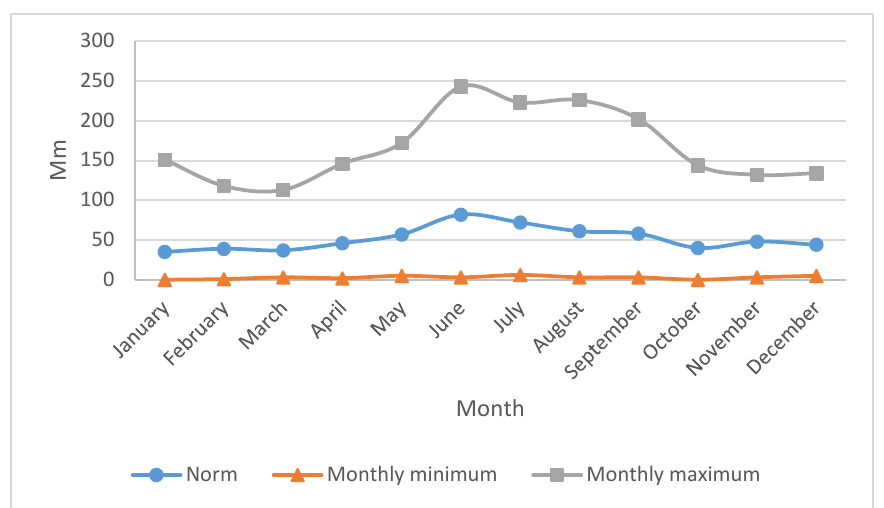
Figure 2: Number of downfalls every month per year